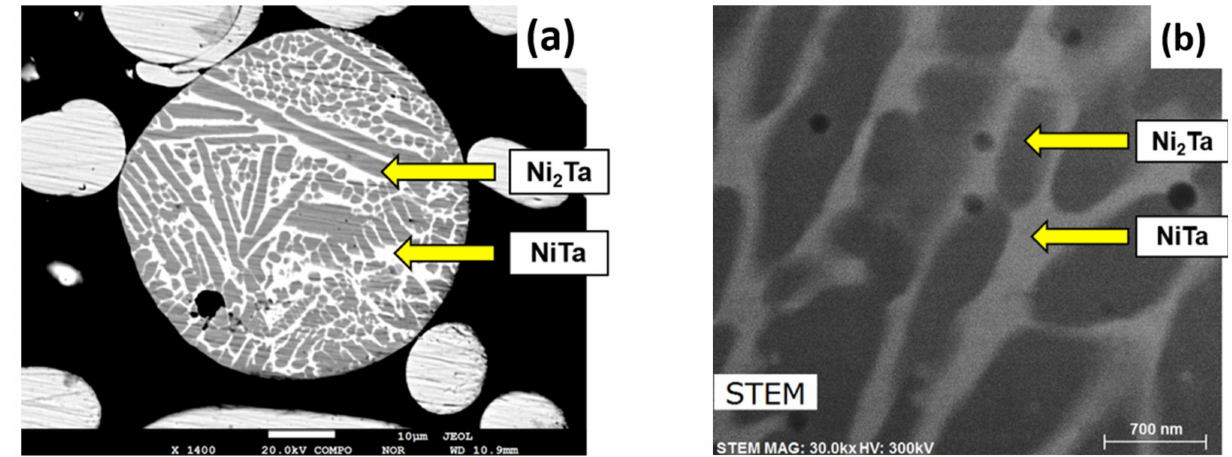
Figure 16. ( a ) SEM micrograph of NiTa powder and ( b ) TEM micrograph of L-PBF